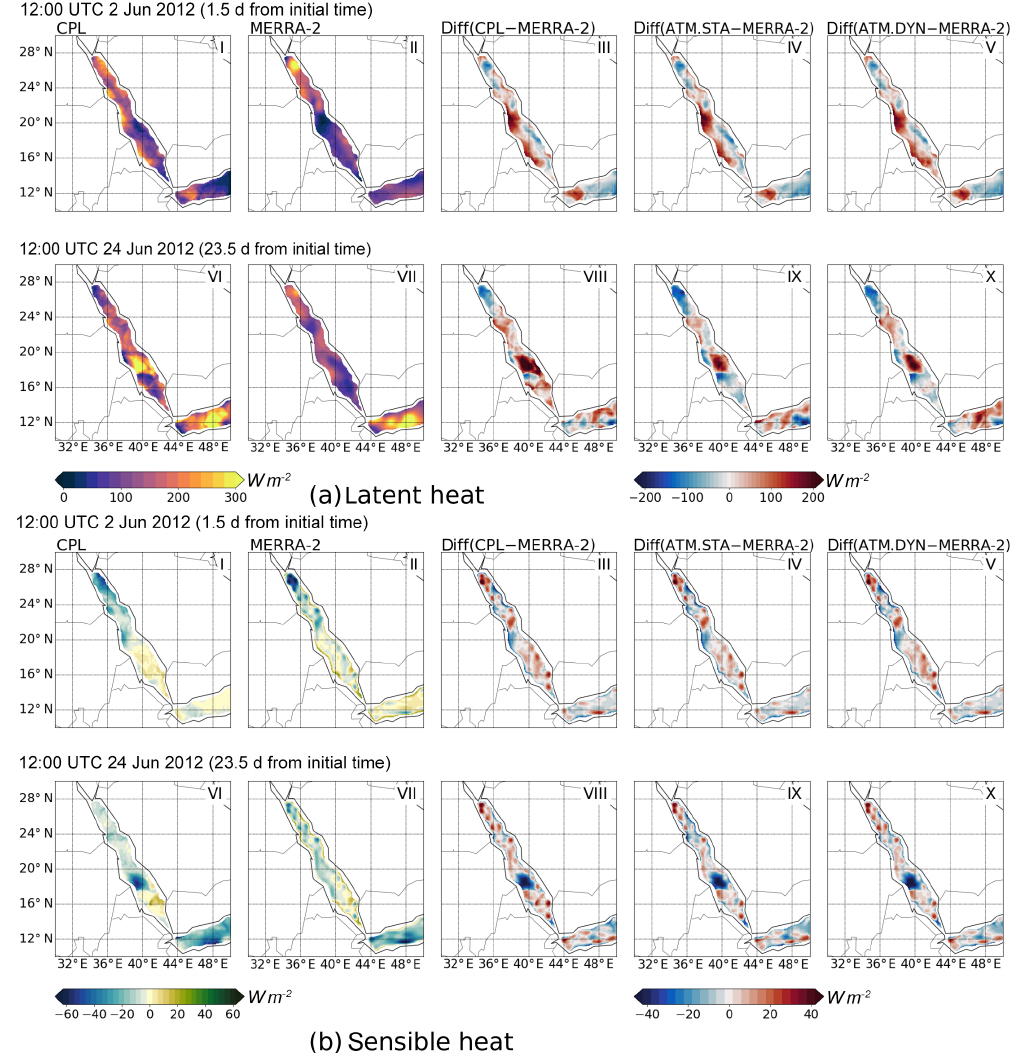
Figure A1. The turbulent heat fluxes out of the sea obtained in CPL, MERRA-2 data, and their difference (CPL − MERRA-2). The differences between ATM.STA and ATM.DYN with MERRA-2 (i.e., ATM.STA − MERRA-2, ATM.DYN − MERRA-2) are also presented. Two snapshots are selected: (1) 12:00UTC 2 June 2012 and (2) 12:00UTC 24 June 2012. The simulation initial time is 00:00UTC 1 June 2012 for both snapshots. Only the heat fluxes over the sea are shown to validate the coupled